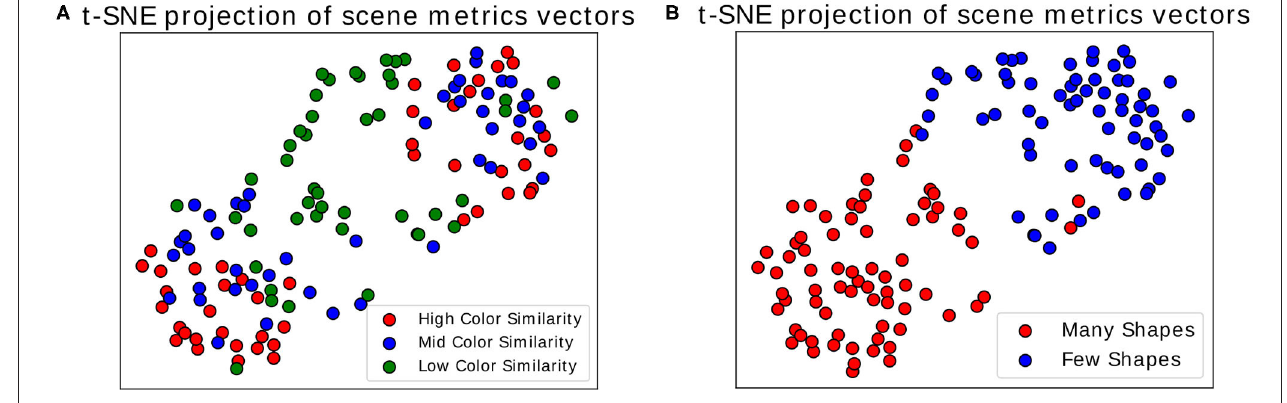
FIGURE 6 | t-SNE projection on two dimensions. Each point represents a scene, represented through the three time-independent metrics. (A) Colors show the variation in color similarity between target and non-target objects. (B) Colors show the variation in number of objects in scenes. Only the data of one participant was used for these figures.